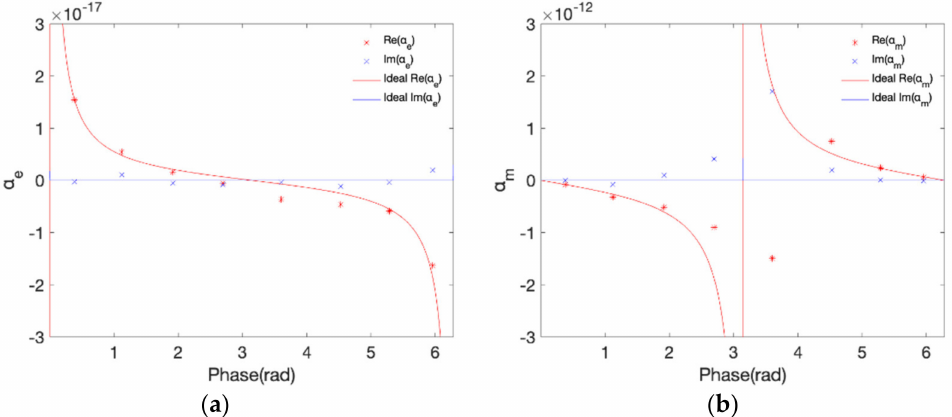
Figure 4. Electromagnetic polarizabilities of the 8 selected unit-cells: ( a ) effective electric polarizability α ef f e ; ( b ) effective magnetic polarizability α ef f m .The solid curves are the electromagnetic polarizabilities of an ideal reflective Huygens source with phase covering the 0-2 π range.